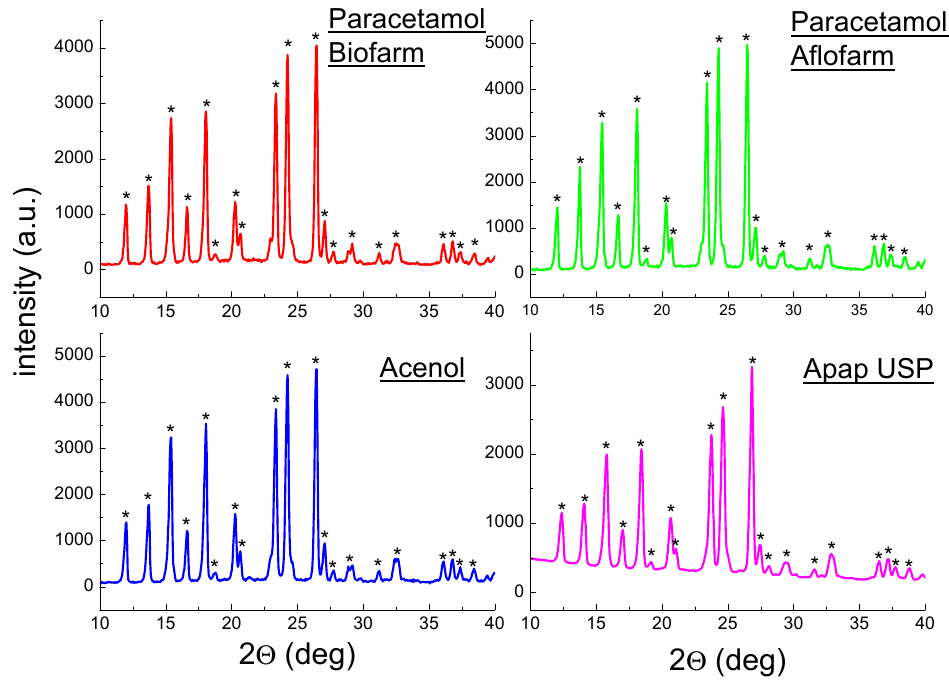
Figure 3. Diffraction patterns for drugs: Paracetamol Biofarm, Paracetamol Aflofarm, Acenol and Apap USP. (*—acetaminophen). Table 2. Comparison of experimental data with data from the ICDD database for the drugs Acenol, Apap USP, Paracetamol Biofarm and Paracetamol Aflofarm containing only ACP as API. No. of Di ff raction